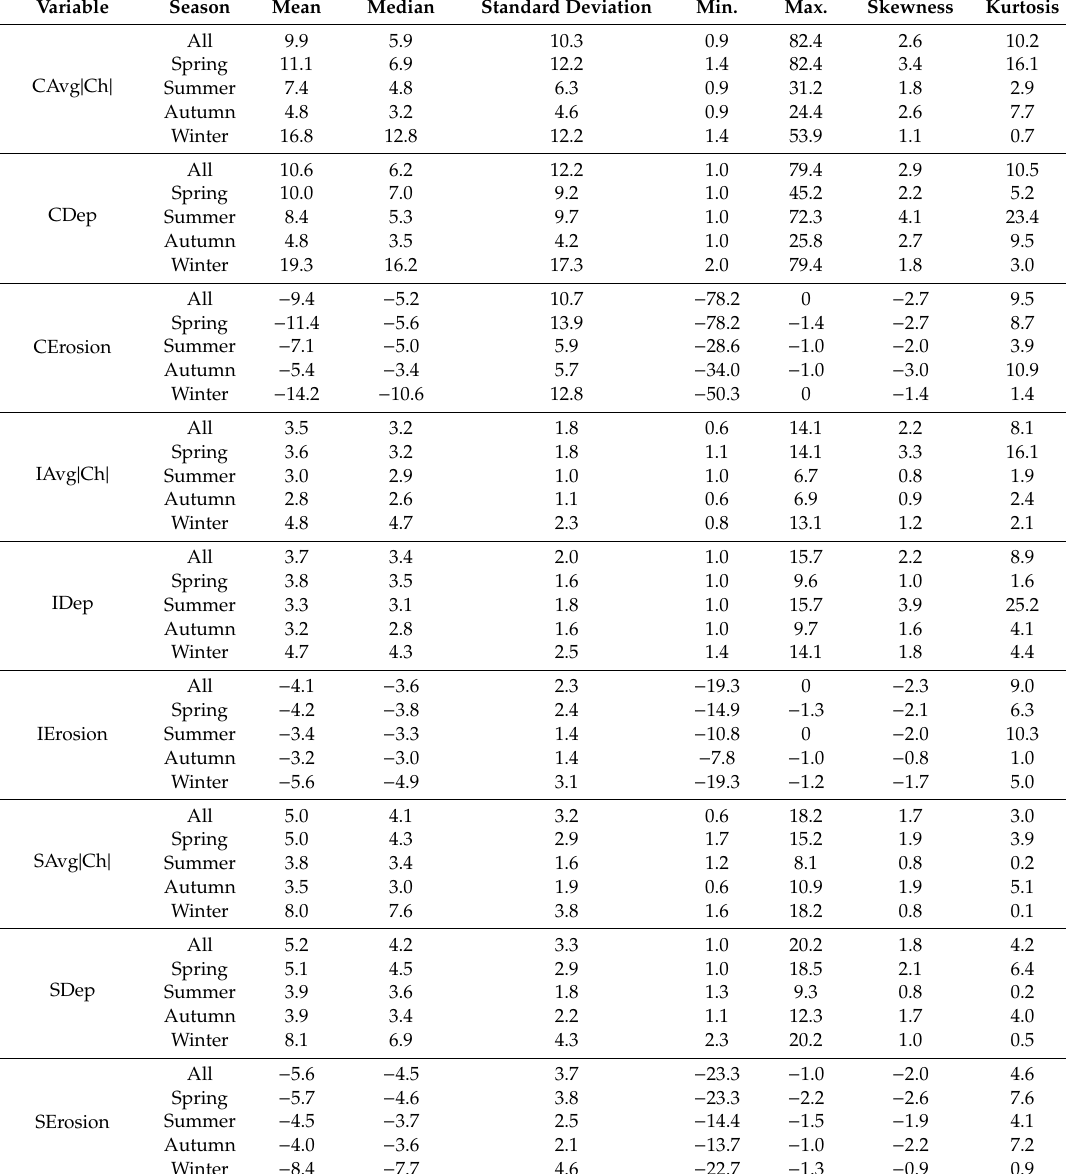
Table 2. Descriptive statistics for erosion variables by measurement period. All values measured in millimeters. C, channel I, interfluve; S,